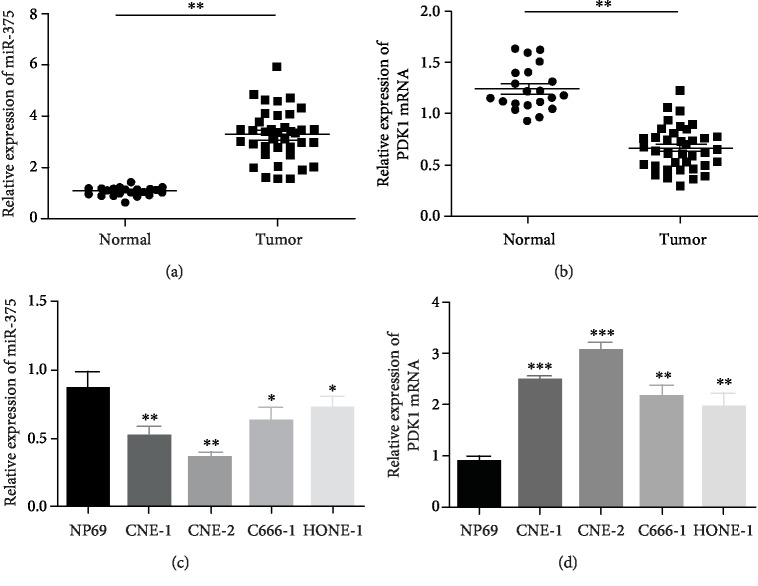
Expression levels of miR-375 and PDK1 in NPC tissues and cell lines were assessed. (a, b) qRT-PCR was performed to measure expression levels of miRNAs and PDK1 in 23 normal samples and in 38 NPC samples. miR-375 is downregulated in NPC tissue, compared with normal tissue, while PDK1 is upregulated in NPC tissue, compared with normal tissue (Student's t-test, ∗∗P < 0.01). (c, d) qRT-PCR was performed to evaluate miR-375 expression in the N69 epithelial normal nasopharynx cell line and NPC cell lines (CNE-1, CNE-2, C666-1, and HONE1). Conversely, levels of PDK1 were markedly increased in NPC cell lines, compared to NP69 (CNE-1, CNE-2, C666-1, and HONE1) (Student's t-test, ∗P < 0.05, ∗∗P < 0.01, ∗∗∗P < 0.001). Cell lines CNE-2 and CNE-1 showed the greatest difference in miR-375 expression levels when compared to NP69 cells and were used for subsequent analyses. Each assay was conducted in duplicate, three times. Values are presented ±s.e.m.